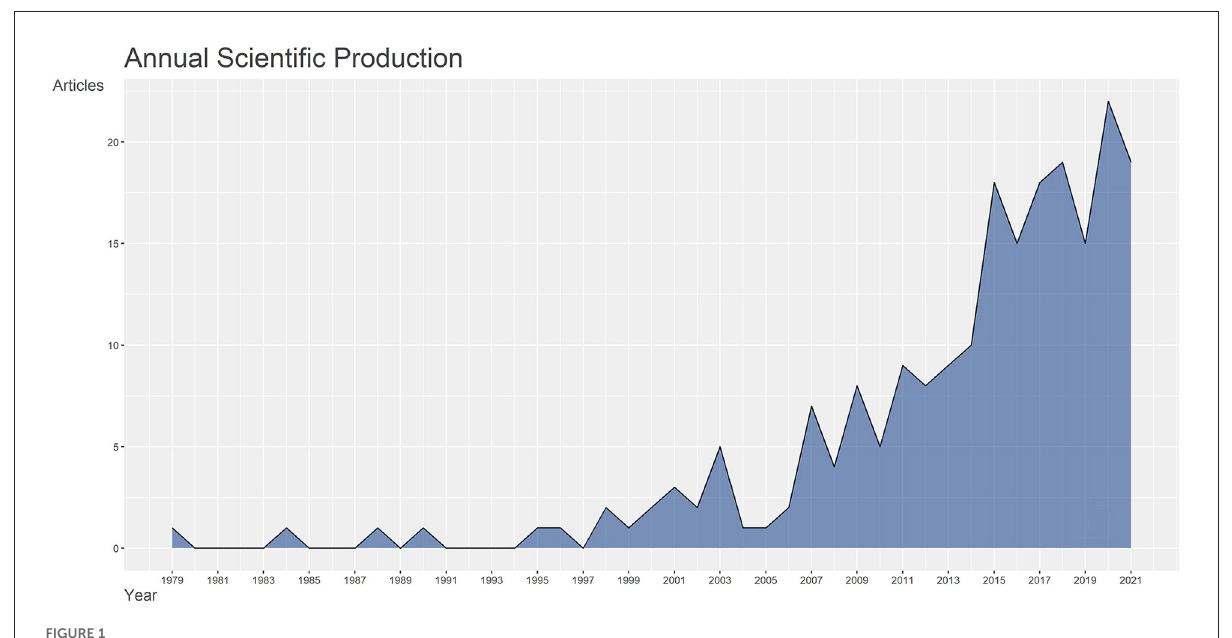
FIGURE1 1979–2021 Annual scientific production in the field of acupuncture for